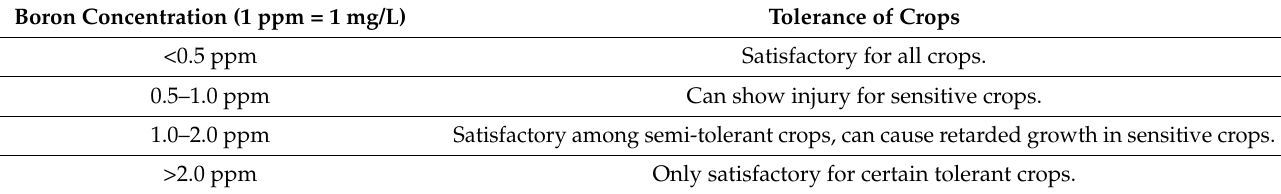
Table 1. Boron hazard for irrigation water (ppm = part per million). Reprinted with permission from Ref. [27], 1994, Elsevier.